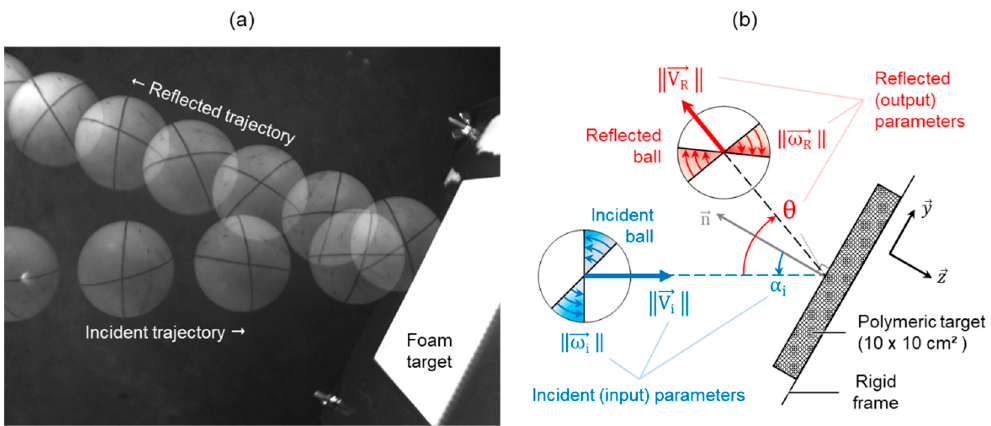
Figure 3. ( a ) Raw image of an impact test showing traces of the ball before and after contact. ( b ) Schematization of the kinematic parameters describing the motion of the table tennis ball prior (incident) and after (reflected) impact.